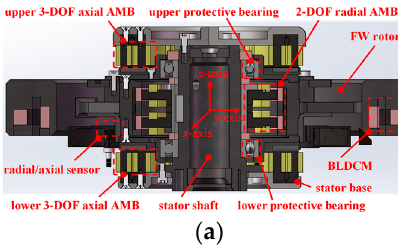
Figure 1. The system view of the 5 ‐ DoF MSFW. ( a ) The main components of the 5 ‐ DoF MSMW; ( b ) the displacement terms of the 5 ‐ DoF MSMW.